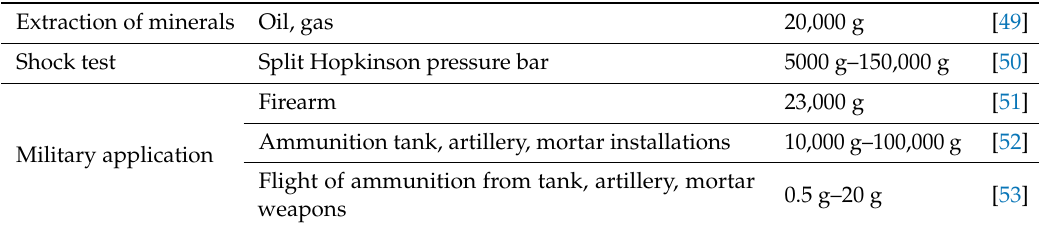
Table 5. Shock amplitudes for heavy duty applications.